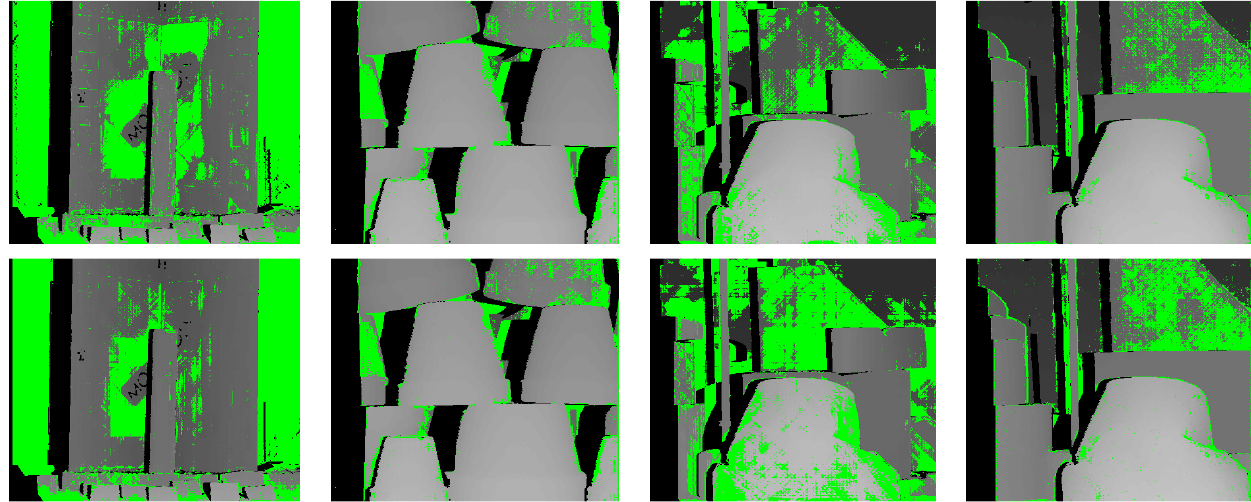
Figure 5. Disparity maps derived from a tuning process (top row) and the suggested method (bottom row). From left to right: stereo- pairs Monopoly , Flowerpots , Lampshade1 , Lampshade2 . In the first two our method (with the use of AD and Census as matching costs) has the best performance; in the other two the optimal parameters of tuning perform best concerning the estimated